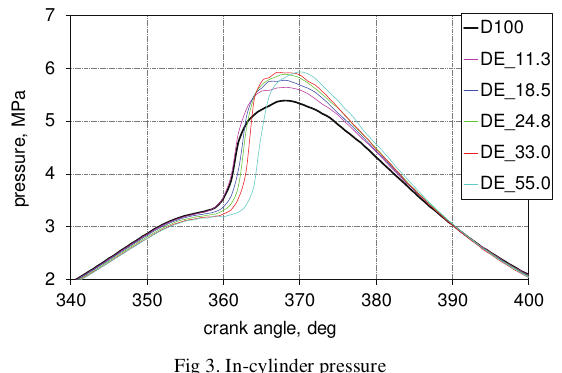
Fig 3. In-cylinder pressure